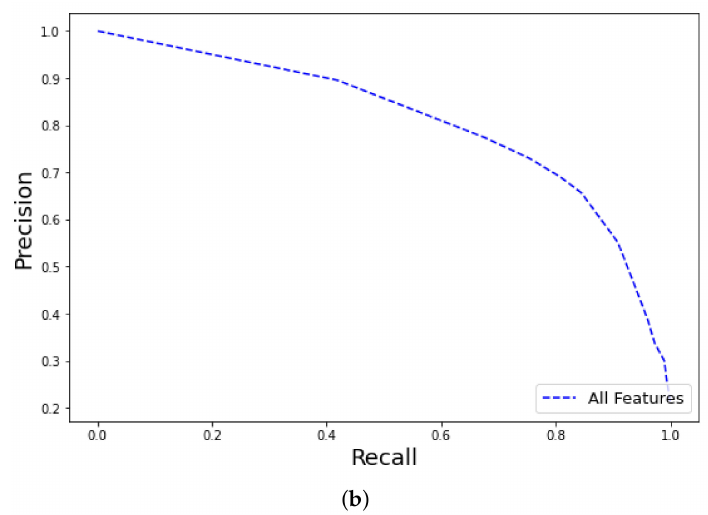
Figure 2. Receiver operating characteristic (ROC) curves for early mortality in ICU patients with thrombosis from MIMIC-III database using all features: ( a ) AUC – ROC curves and comparison with traditional scores (APS, Acute Physiology Score; LODS, Logistic Organ Dysfunction Score; MLODS, Multiple Logistic Organ Dysfunction Score; OASIS, Outcome and Assessment Information Set; SAPS, Simplified Acute Physiology Score; SIRS, Systemic Inflammatory Response Syndrome; SOFA, Sequential Organ Failure), ( b ) Precision–recall (PR) curve.